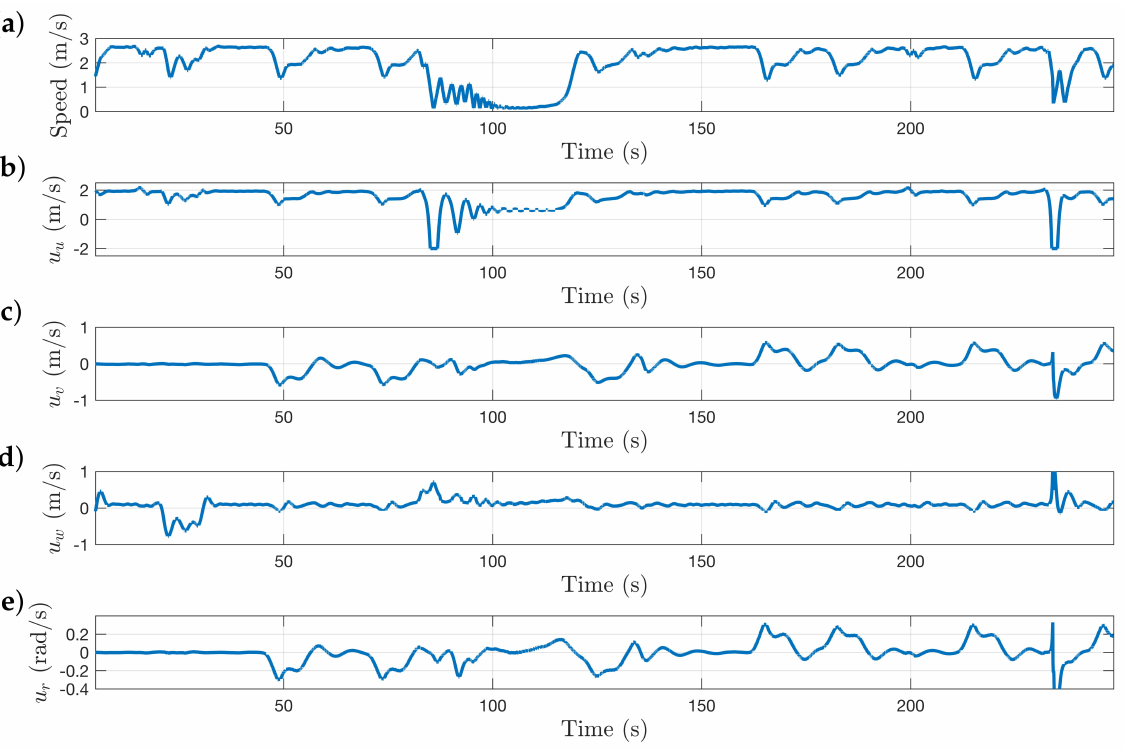
Figure 14. Plots showing speed of system and control commands. ( a ) Speed of system. ( b ) Forward speed command. ( c ) Lateral speed command. ( d ) Vertical speed command. ( e ) Yaw rate